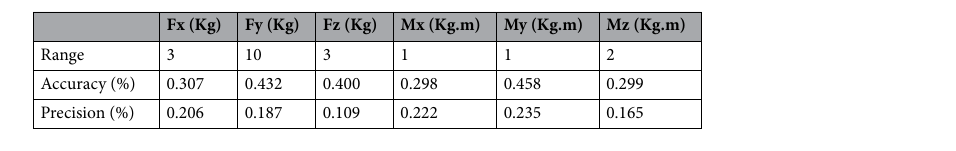
Table 2. Static calibration performance of balance.